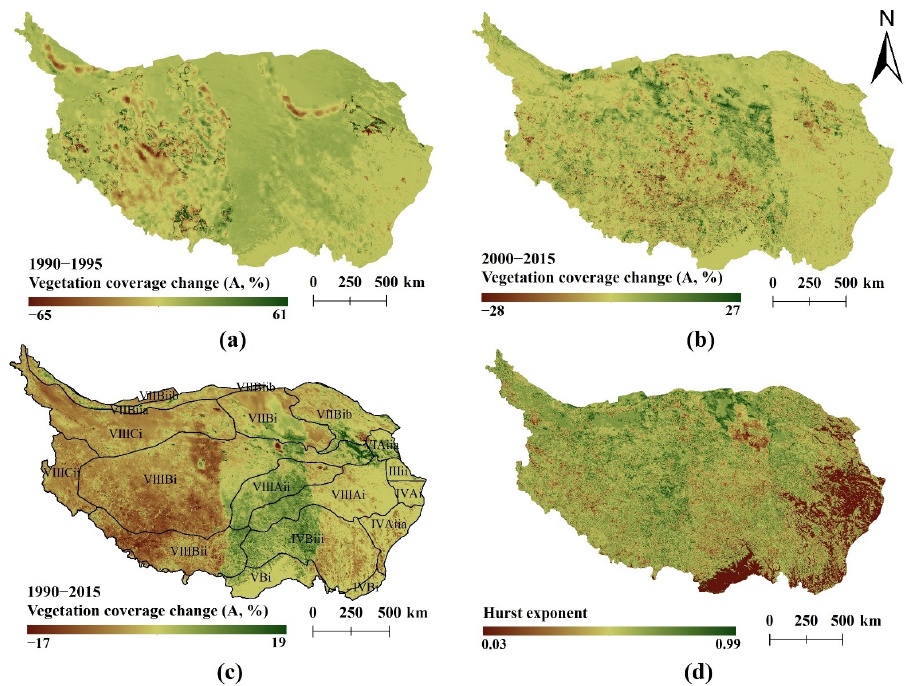
Figure 4. The vegetation change trend and Hurst index on the Qinghai–Tibet Plateau, ( a ) is the vegetation change trend from 1990 to 1995, ( b ) is the vegetation change trend from 2000 to 2015, ( c ) is the vegetation change trend from 1990 to 2015, ( d ) is the Hurst index from 1990 to 2015.